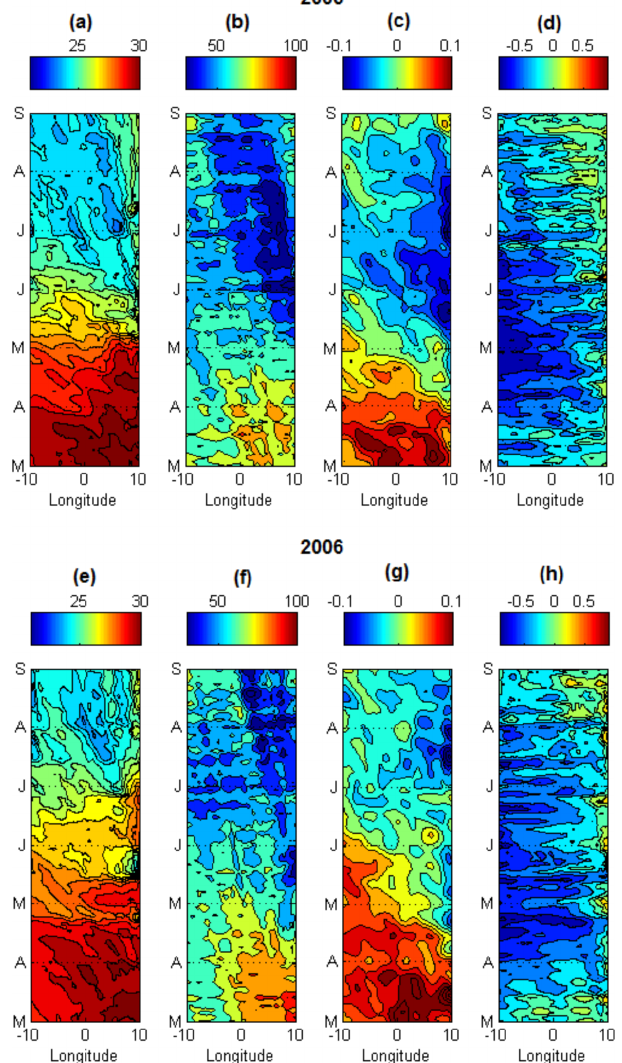
Figure 9. Time–longitude diagrams at 3 ◦ S between 10 ◦ W and 10 ◦ E and from 2-day averaged model outputs from 1 March to 31 August 2005 and 2006 of (a, e) the sea surface temperature ( ◦ C), (b, f) the 20 ◦ C isotherm depth (m), (c, g) the sea level anomalies from AVISO data (m), and (d, h) the zonal component of surface velocity (ms − 1